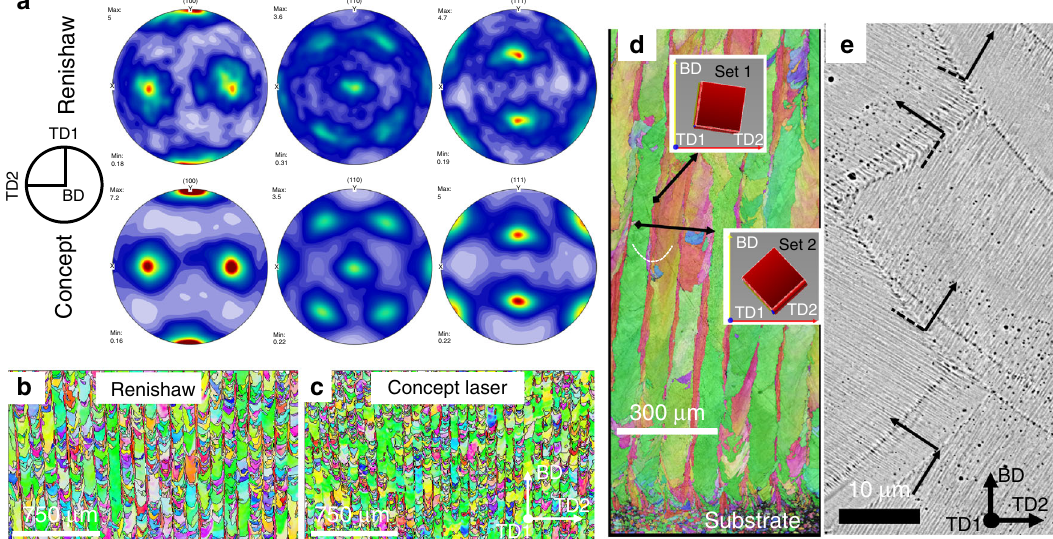
Fig. 5 Microstructure in the 316L and HEA fabricated by linear bidirectional scanning without rotation for subsequent layers. a Pole fi gures of crystallographic orientations observed in 316L fabricated by a Renishaw AM250 and Concept Laser. b , c Inverse pole fi gures along the building direction of crystallographic orientations in 316L fabricated by a Renishaw AM250 and Concept Laser, respectively. d Variation of microstructure from the fi rst layer of deposition on a wrought steel substrate towards the top of a build of the HEA fabricated by a Reninshaw AM250. e Side-branching dominantly occurred between adjacent melt tracks in a HEA